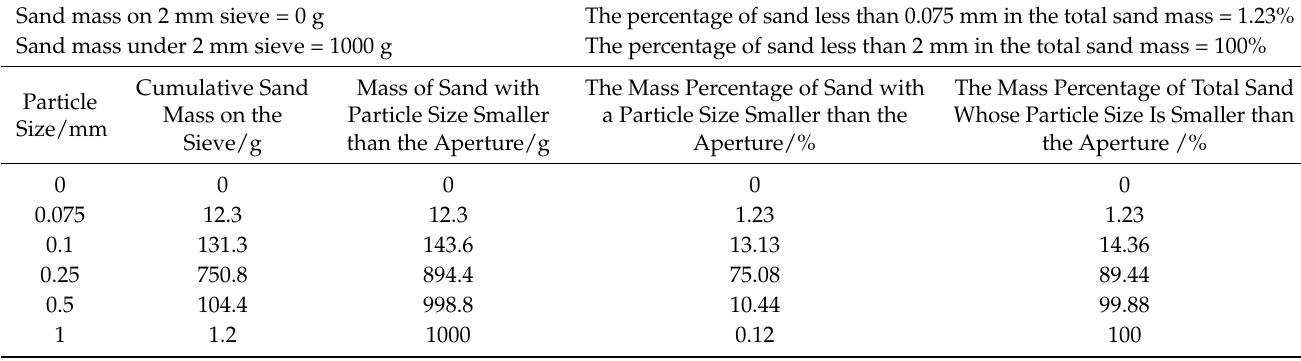
Table 1. Particle size gradation of aeolian sand in the Tengger Desert. The percentage of sand less than 2 mm in the total sand mass =